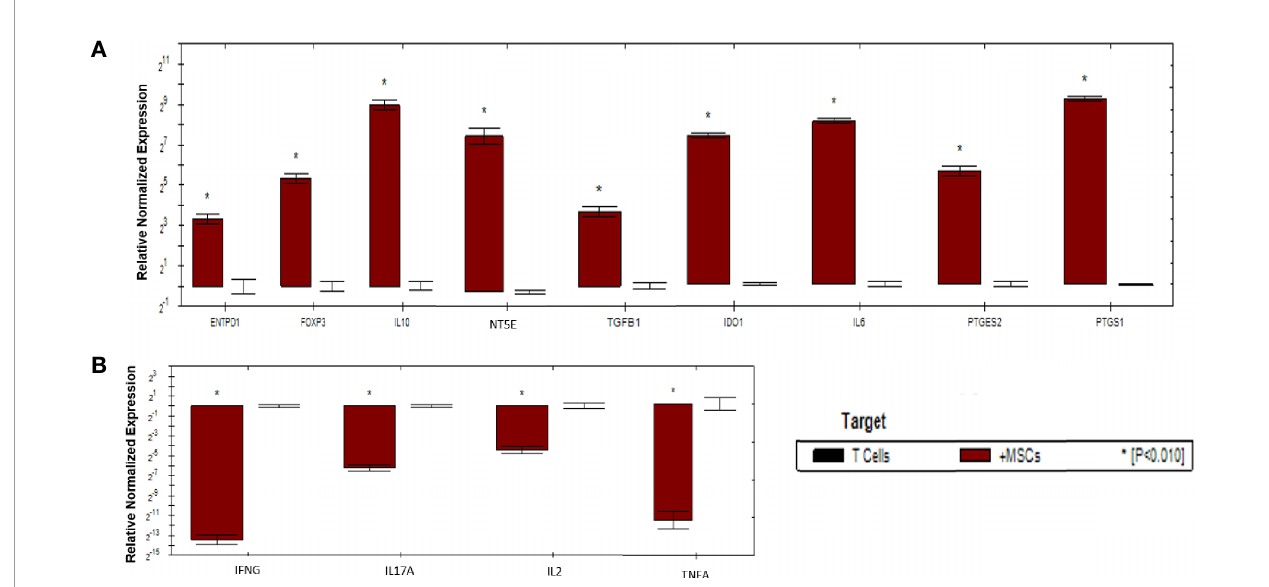
FIGURE 6 | Relative normalized expression of immunomodulatory and immunostimulatory genes of activated T cells after co-cultured with primed WJ-MSCs. (A) upregulated genes. (B) downregulated genes. T cells from four patients were used. Results were normalized to 18S rRNA Each sample was performed in triplicate, and a mean value was calculated. Data were analyzed according to 2 − DD CT method using CFX Maestro ™ Software - Bio-Rad. * p ≤ 0.01 and fold change ≥ 1.5.